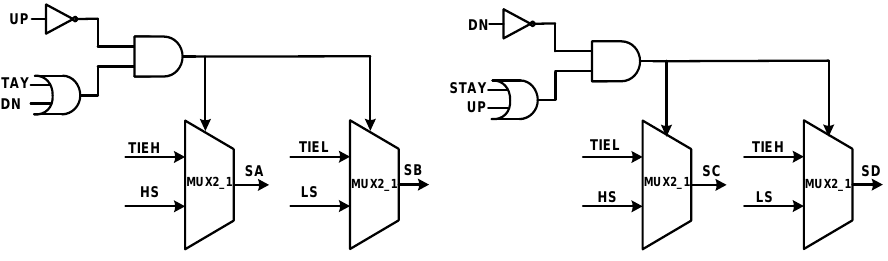
Figure 4. The gate driver controller.